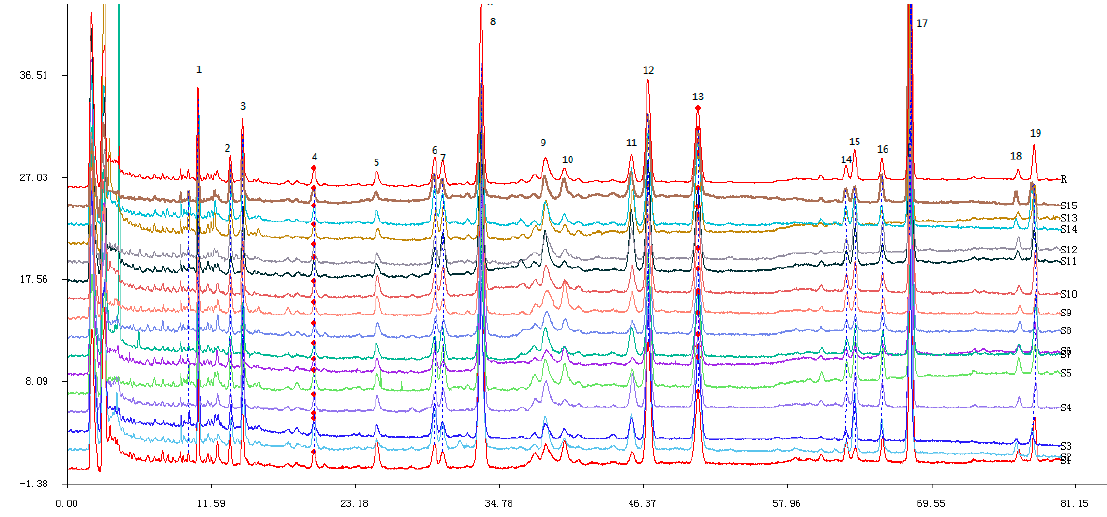
Figure 1. Overlaid HPLC chromatograms of samples from No. S1–S15. The common pattern (marked R)